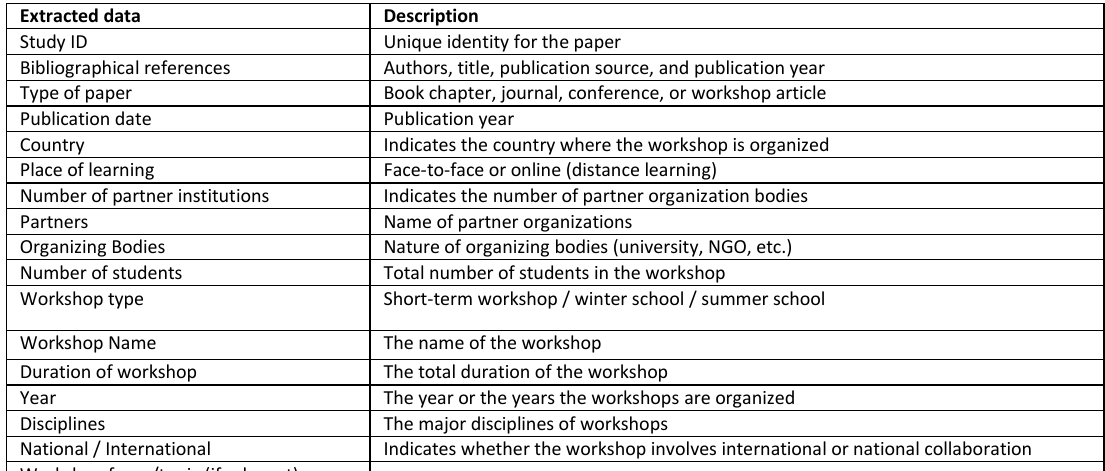
Table 3 Data extraction for each study